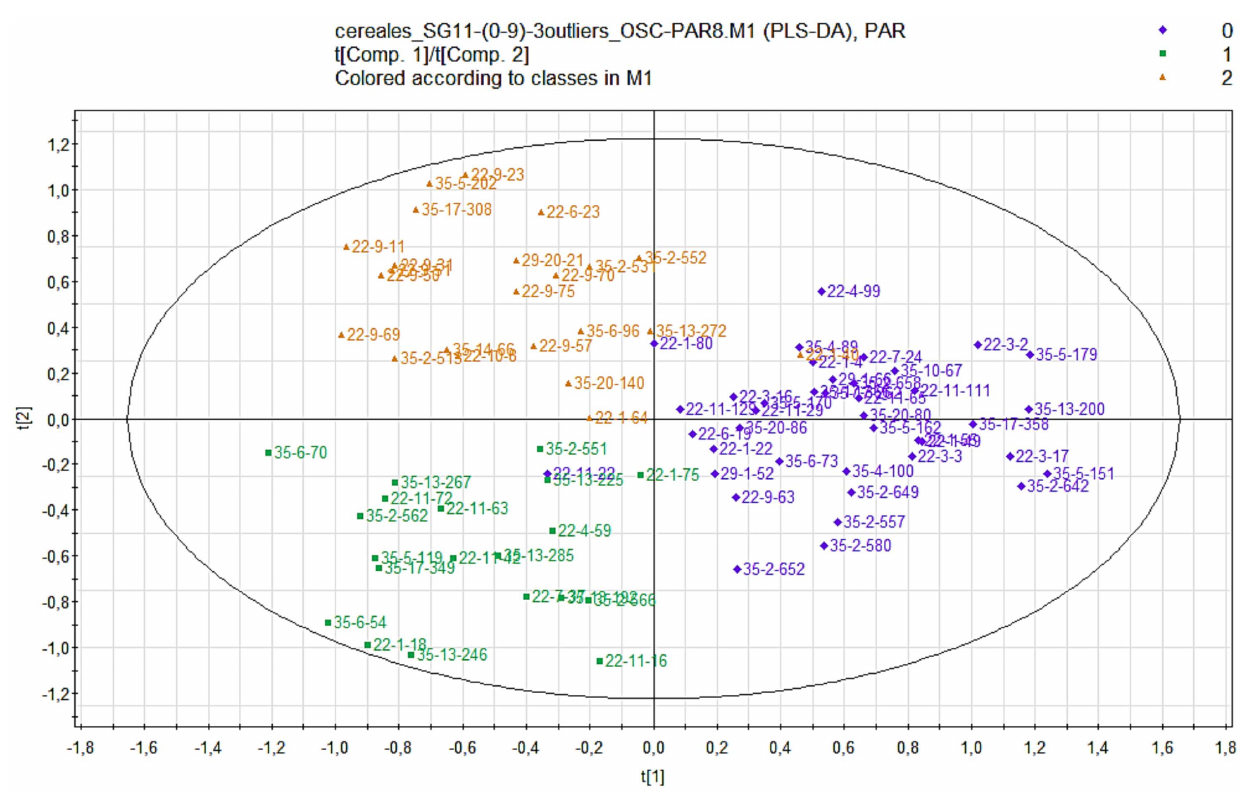
Figure 2. PLS-DA score plot from the 1 H NMR urinary metabolic profiles from 83 pregnant women. The score plot is the projection of the observations onto the first two latent variables. The PLS-DA model, constructed on OSC-filtered and Pareto-scaled data, includes 4 latent variables (N=83; R2=90.7% and Q2=0.53). Three groups according to the percentage of the surface of land dedicated to cereal crops in the town of residence in early pregnancy: purple: group 0: 0–17%, green: group 1: . 17–25%; orange: group 2: .